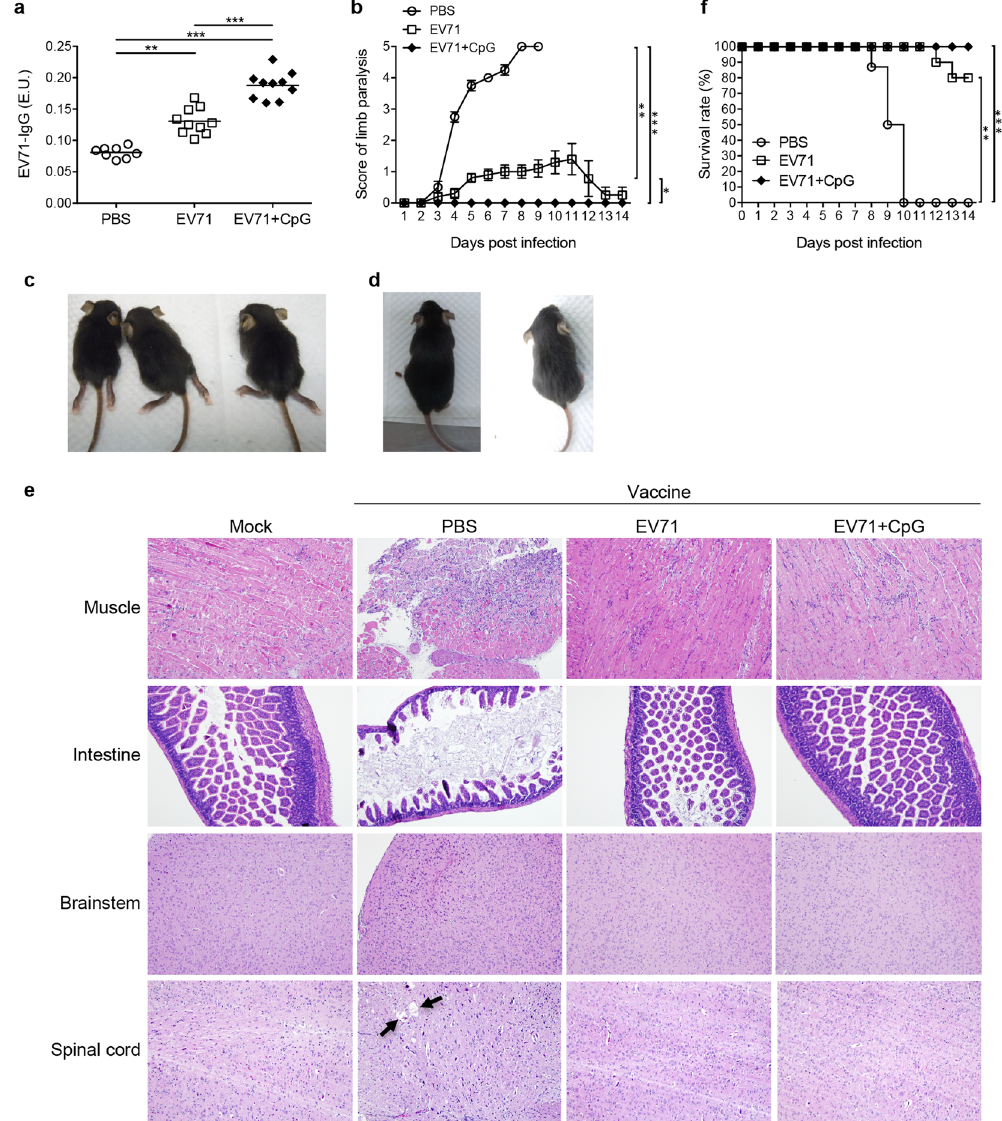
Figure 8. EV71-specific antibody responses, neurological symptoms, pathological changes, and lethality in mice infected with EV71 of the C2 genotype. hSCARB2-Tg mice were intranasally immunised twice with PBS, EV71 (1 μ g), or EV71 (1 μ g) plus CpG (4 μ g) on postnatal days 1 and 2 and were then s.c. challenged with 3 × 10 6 pfu of the 5746 EV71 strain. ( a ) Serum samples were collected from each mouse on postnatal day 8 before the mouse was s.c. challenged with 3 × 10 6 pfu of the 5746 EV71 strain, and the collected samples were assayed to determine the titres of EV71-specific IgG. ( b ) CNS disorder-like limb paralysis was scored according to the criteria described in the Methods section. Representative images showing symptoms of ( c ) the PBS- immunised group with limb paralysis and ( d ) protected mice in the EV71 or EV71 + CpG immunised group at day 7 postinfection with EV71 virus. ( e ) Histological examination of EV71-infected mice. The animals were sacrificed in the moribund state, and paraffin sections of the organs, including the muscle, intestine, brainstem, and spinal cord, were stained with H&E. Normal tissues were collected from mice without EV71 challenge as a mock control. ( f ) Daily survival rate, monitored after 8-day-old hSCARB2-Tg mice were s.c. infected with 3 × 10 6 pfu of the 5746 EV71 strain. Values shown are means ± SEMs of 8–10 mice in each experimental group; * p < 0.05, ** p < 0.01, *** p <